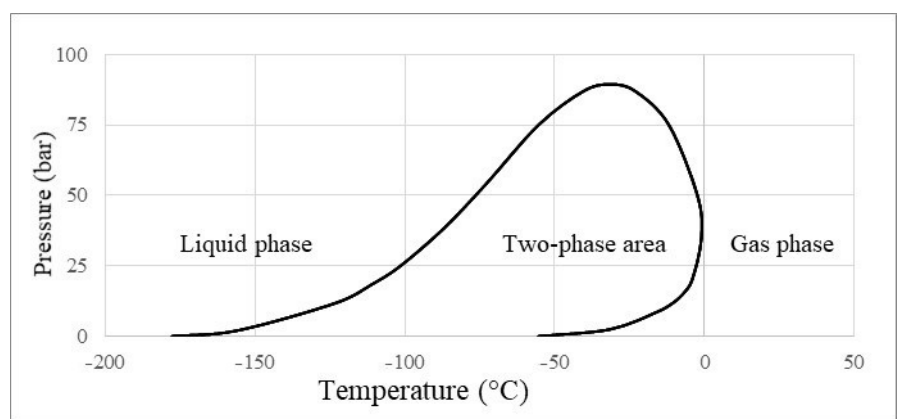
Figure 1. Illustration of a phase diagram of a typical natural gas. The diagram shows the pressure 1 Calculated based on value for kg/Nm 3 [16]. 2 Calculated based on value for kg/Sm 3 [17]. 3 Calculated based on referenced (bar) as a function of temperature ( ◦ C) of a typical natural gas. To the left in the diagram the gas is data on density, upper and lower gravimetric heating values [13,16,21,22]. liquefied (LNG), in the two-phase area gas and liquid coexist, and to the right in the diagram only gas phase exists. Data are based on [9].